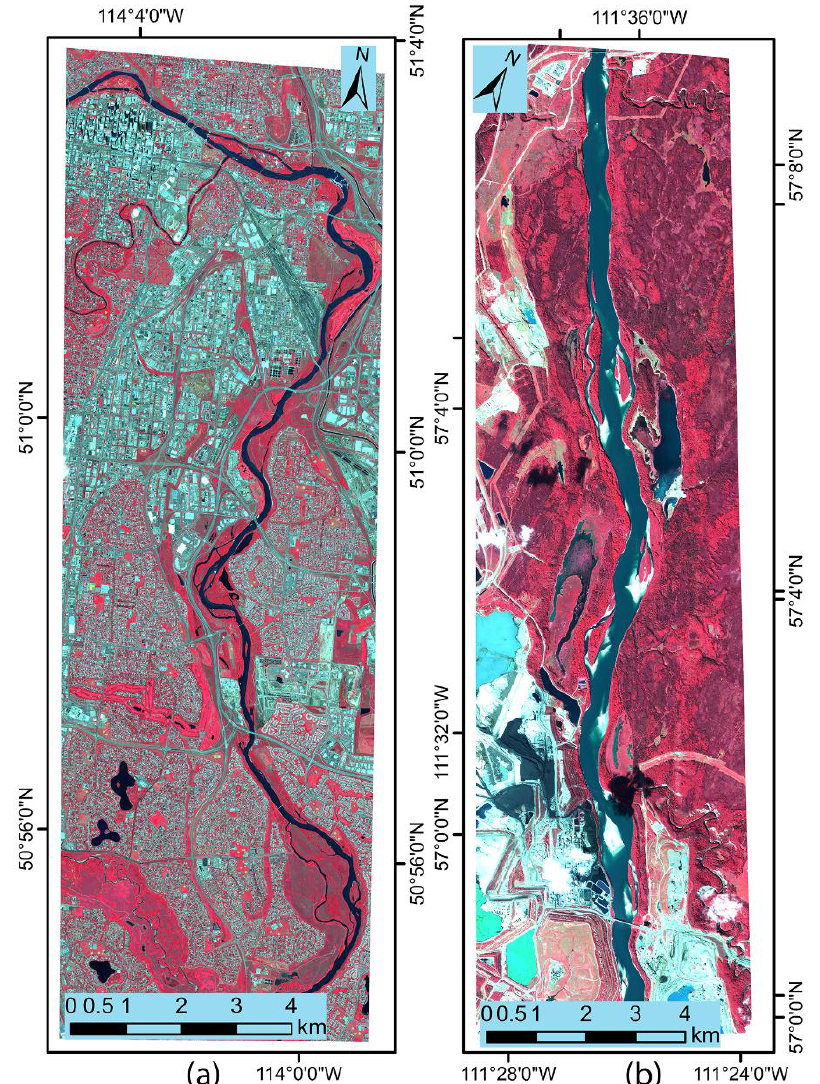
Figure 1. The study sites: The false-colour (band 7, 5, and 3) of WV-2 images for the Bow River site ( a ) and the Athabasca River site ( b ). Both river sections are in Albert,